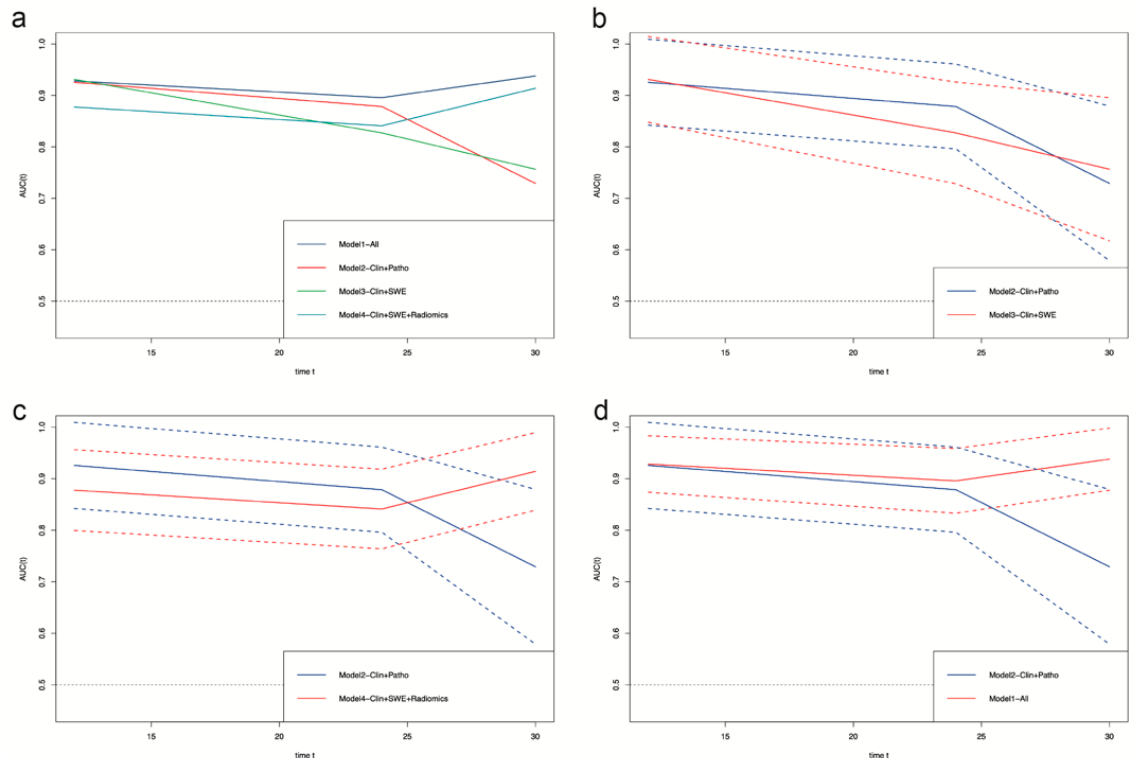
Figure 4. Time-dependent ROC of survival prediction models based on Cox regression. ( a ), the comparison of time-dependent ROC among all four models. ( b ), the comparison of time-dependent ROC between Model2–Clin+Path and Model3–Clin+SWE. ( c ), the comparison of time-dependent ROC between Model2–Clin+Path and Model4–Clin+SWE+Radiomics. ( d ), the comparison of time-dependent ROC between Model2–Clin+Path and Model1–All. Clin, clinical features of eGFR at baseline, Scr at baseline, and ACR at baseline; Patho, pathological features of tubular atrophy and artery/arteriole hyalinosis; SWE, elastography parameters of median SWE value of left renal cortex and mean SWE value of left renal sinus; Radiomics, radiomics signatures of cortex wavelet LLH first order Skewness, cortex wavelet HLH gldm SmallDependenceHighGrayLevelEmphasis, cortex wavelet HHL glszm